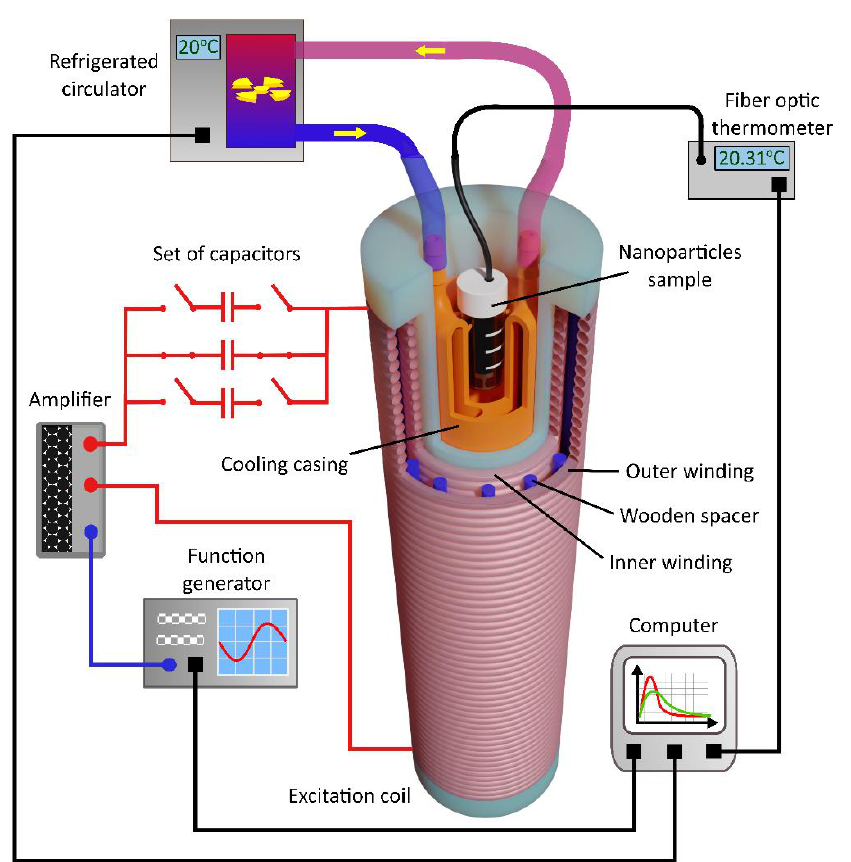
Figure 4. Schematic diagram of the measurement system with detection probe for calorimetric method. The excitation module consists of the function generator, amplifier, set of different capacitors, and excitation coil (the same as in the setup for magnetometry). Temperature stabilization of the sample is provided by the refrigerated circulator. The fiber optic thermometer records the temperature of the sample.